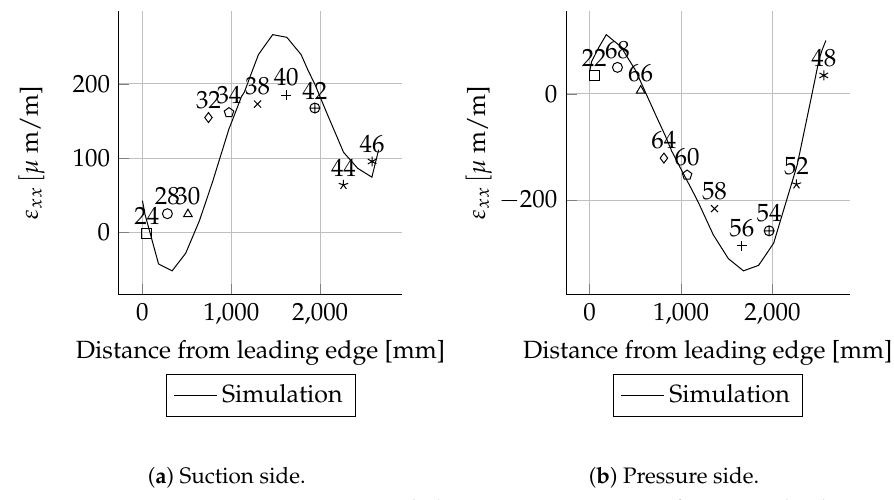
Figure A54. Strain comparison ε LL at radial position R = 5000mm for torsion load case LC_1.